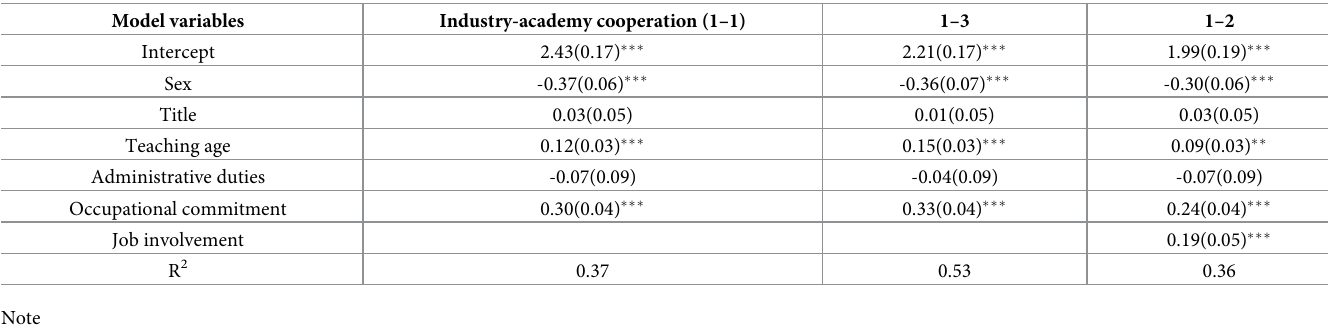
Table 6. Results of mediation effect